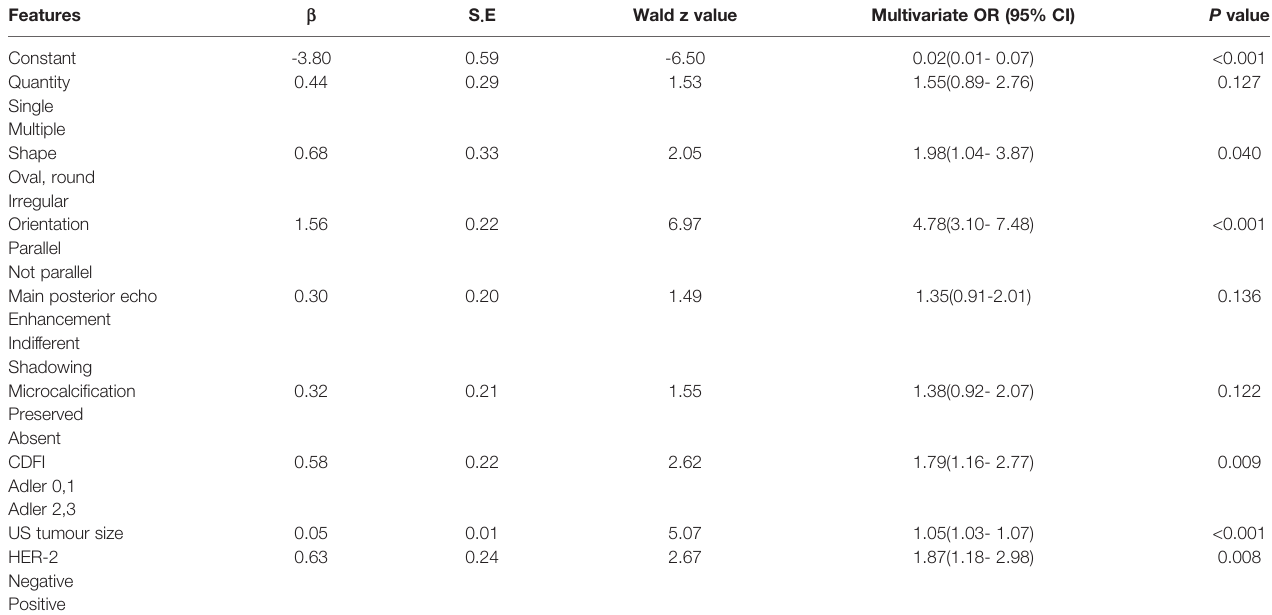
TABLE 3 | Results of the